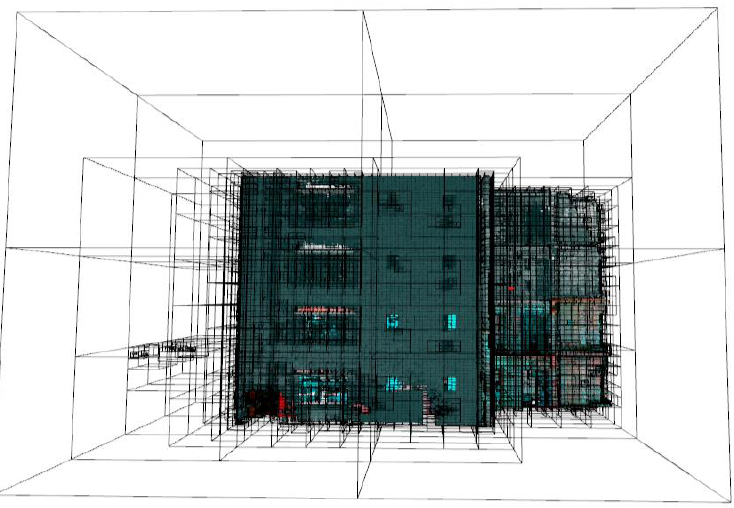
Figure 15. Spatial sub-division of the input point cloud.